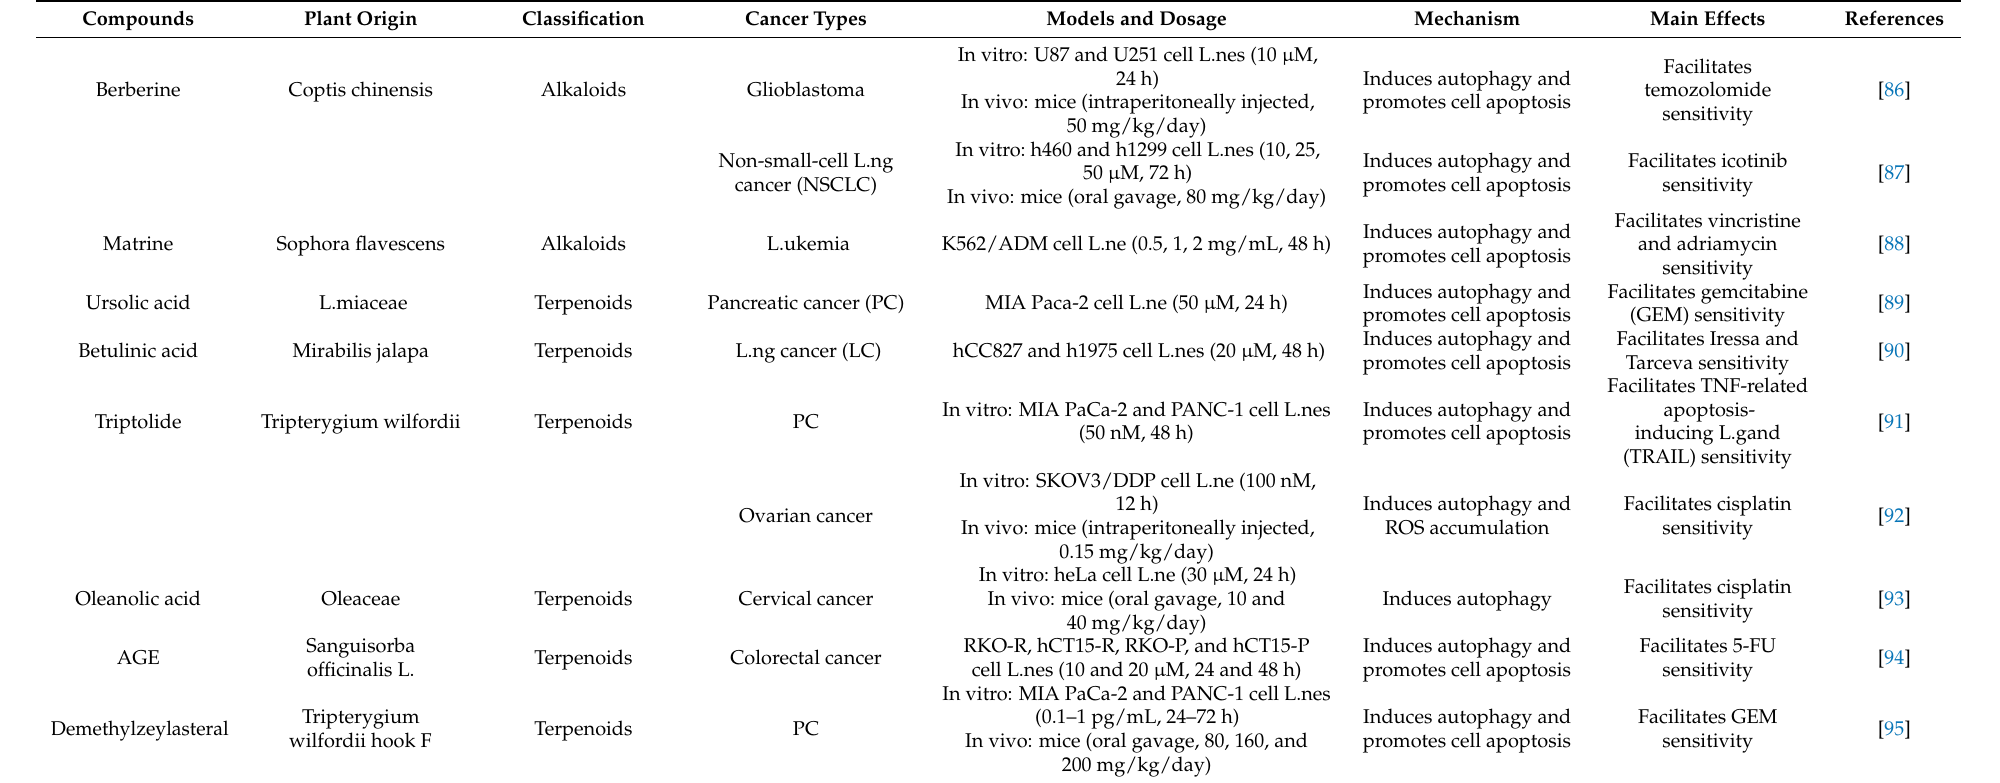
Table 2. Natural products that act against tumor drug resistance by inducing L.thal